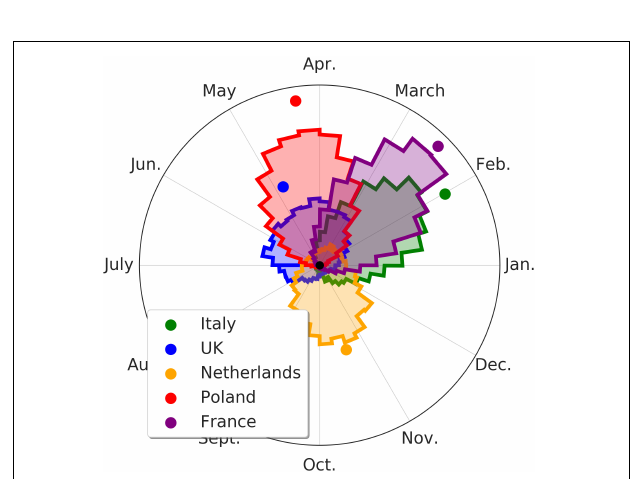
FIGURE 7 | Month of maximum variation of the seasonality of the NU-AGE index. The colored area represents the distribution of plausible values of the NU-AGE index for the peak period. Higher and thinner peaks represent a higher degree of certainty on the estimation of the peak period. The colored dots represent the average peak location (and degree of certainty). The NU-AGE index in the English and the Netherlands subjects undergoes a lower seasonality